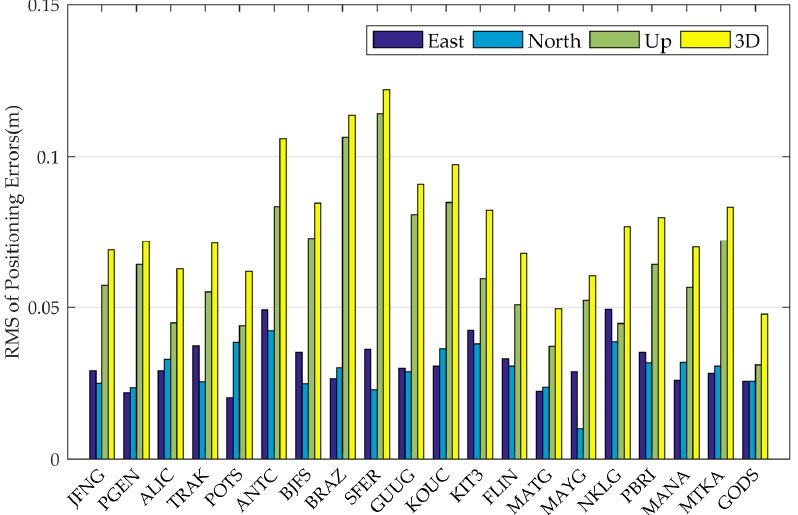
Figure 12. Daily RMS values of PPP positioning results at the 20 selected global IGS stations using MADOCA real-time products.